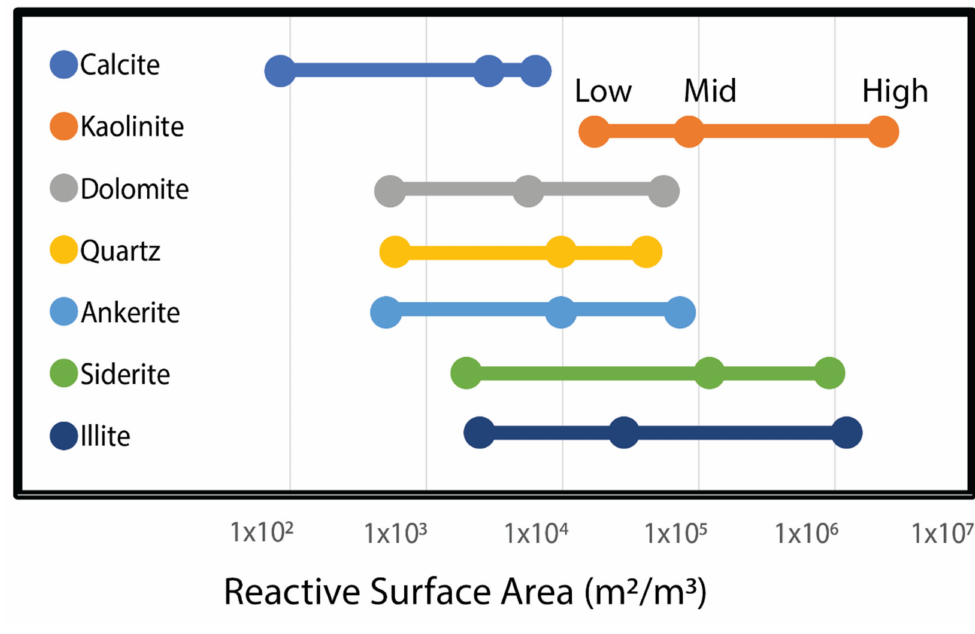
Figure 2. Low, mid, and high values of the reactive surface area of seven